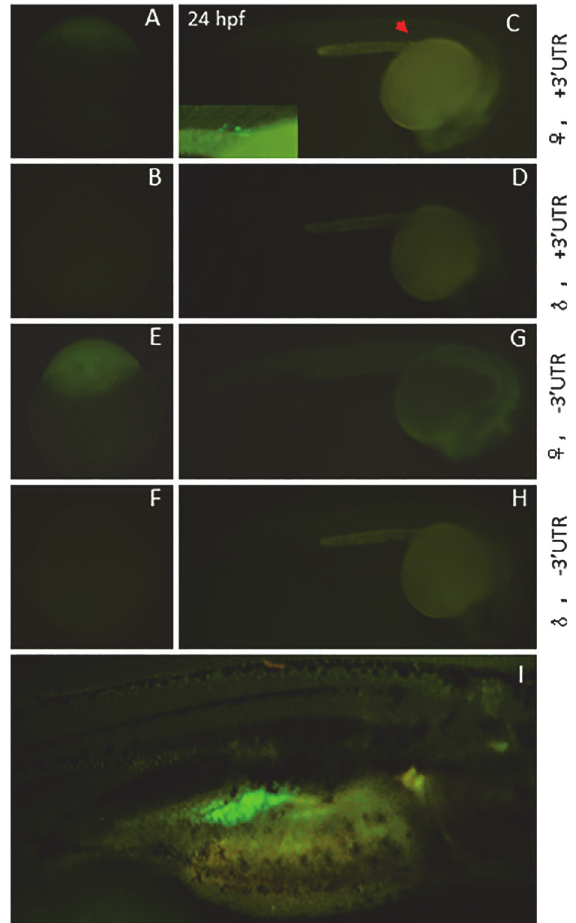
zebrafish. The fluorescent protein expression was monitored using fluorescence microscopy. A-D) Expression pattern of the transgene in dnd +3 ’ UTR :NTR-EGFP transgenic fish. A and C, the expression pattern following female transmission, with PGC-specific expression at 24 hpf stage (the inset in C shows the EGFP- positive PGCs in transgenic embryos); B and D, no fluorescence expression following male transmission. E-